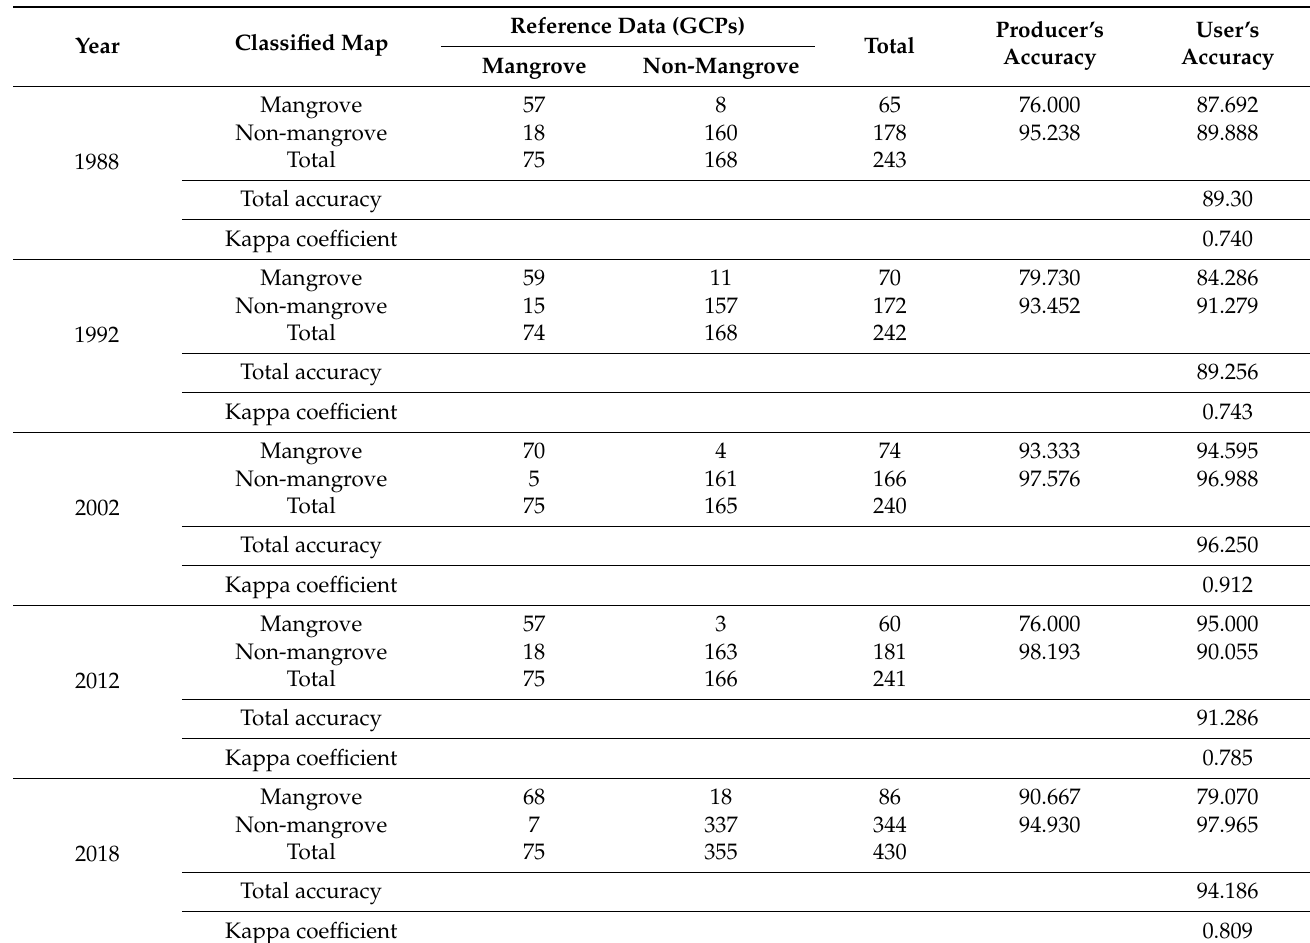
Table 3. Confusion Matrix and Kappa Coefficient for 1988, 1992, 2002, 2012 and 2018 Landsat